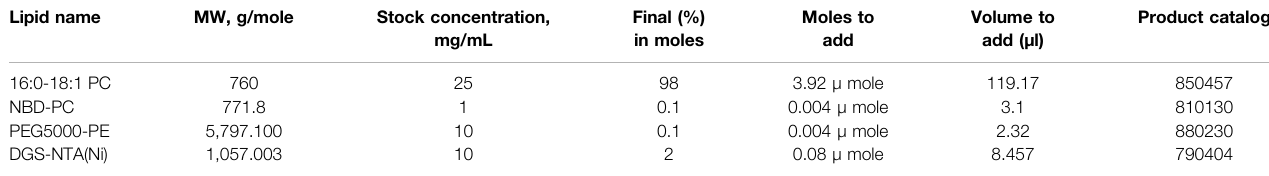
TABLE 5 | Example calculations for converting lipid moles to volume. Lipid